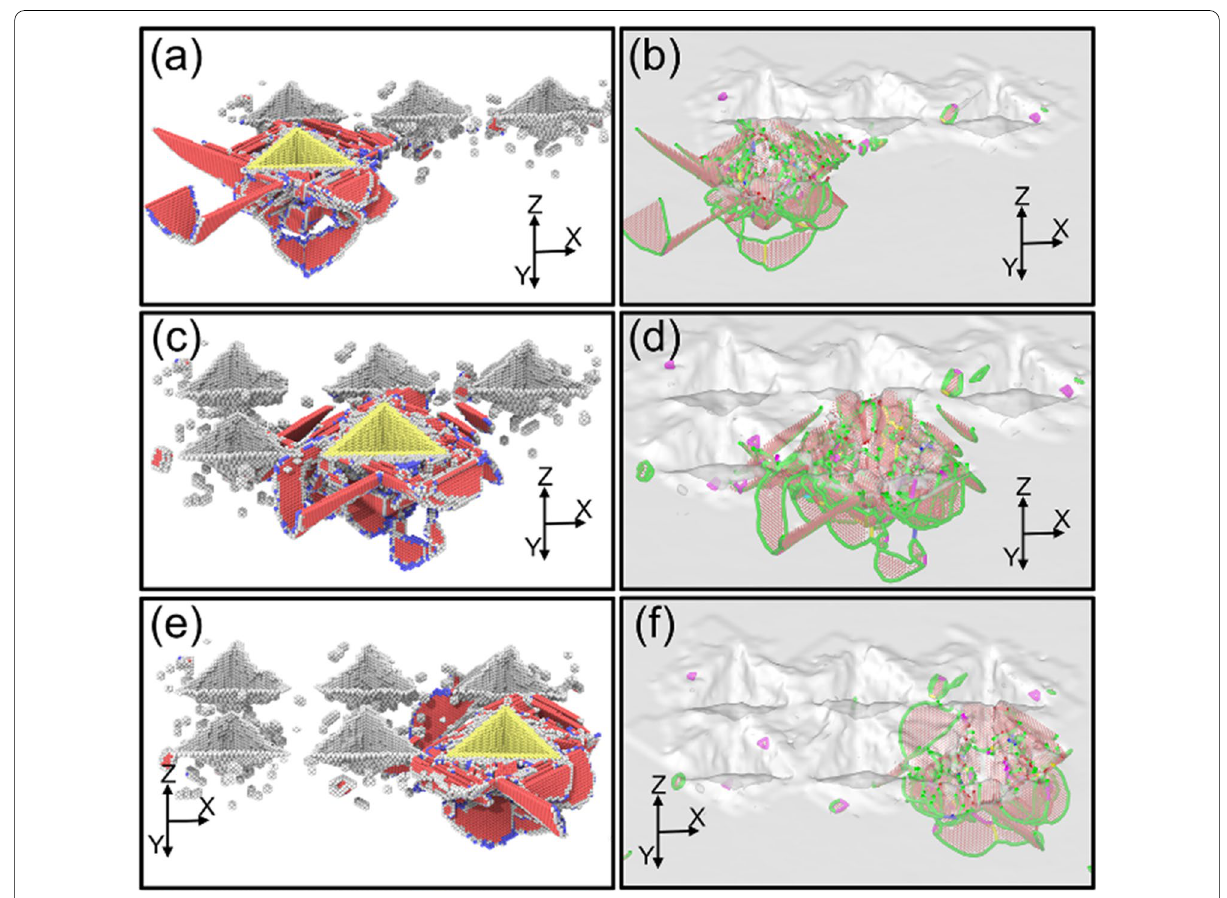
Fig. 7 Dislocation structures generated in Single-Indenter indentation process with the spacing of 10 nm a CNA snapshot in the fourth indentation, b DXA snapshot in fourth indentation, c CNA snapshot in the fifth indentation, d DXA snapshot in the fifth indentation, e CNA snapshot in the sixth indentation, f DXA snapshot in the sixth